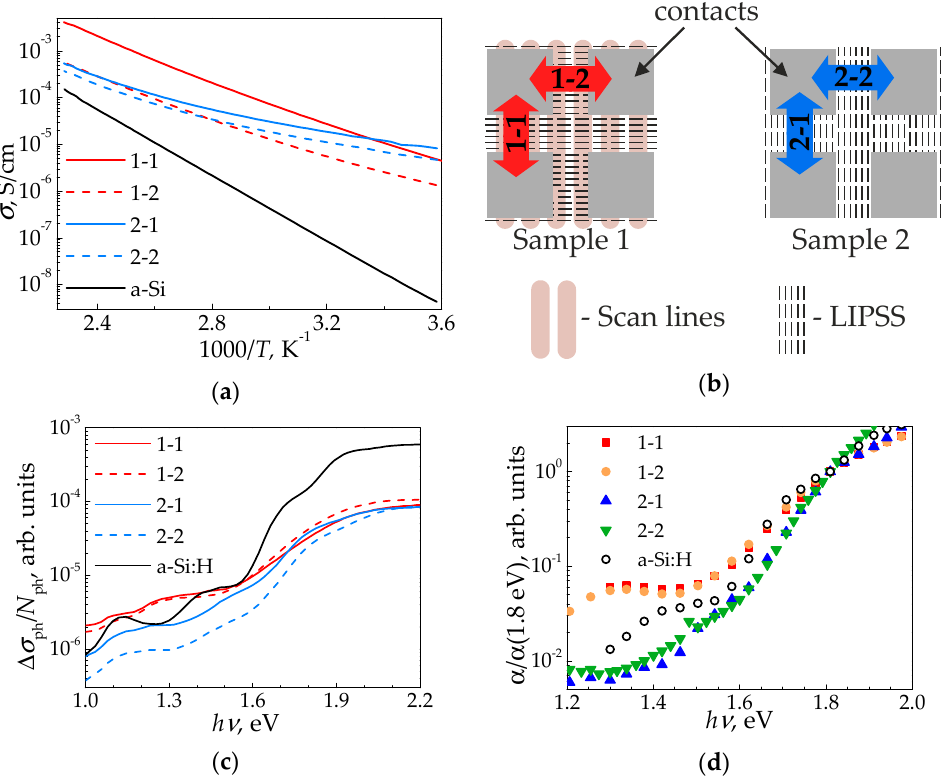
Figure 5. ( a ) Temperature dependencies of dark conductivity σ . ( b ) Electric contacts geometry relative to scan lines and LIPSS. Directions of the electric field vector E are marked as 1-1, 1-2, 2-1, and 2-2. ( c ) Spectra of photoconductivity σ ph , normalized on the number of photons N ph . ( d ) Spectra of absorption coefficient α , normalized on its value at the mobility gap with for a-Si:H (1.8 eV).